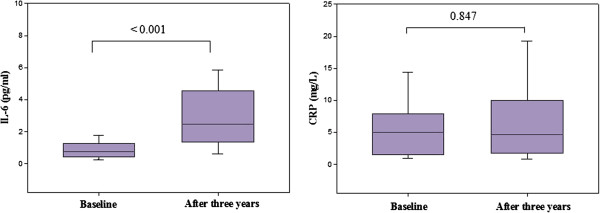
Plasma concentration of IL-6 and CRP at baseline and after three years. IL-6 = Interleukin 6; CRP = C-reactive protein. Data show medians with interquartile range.